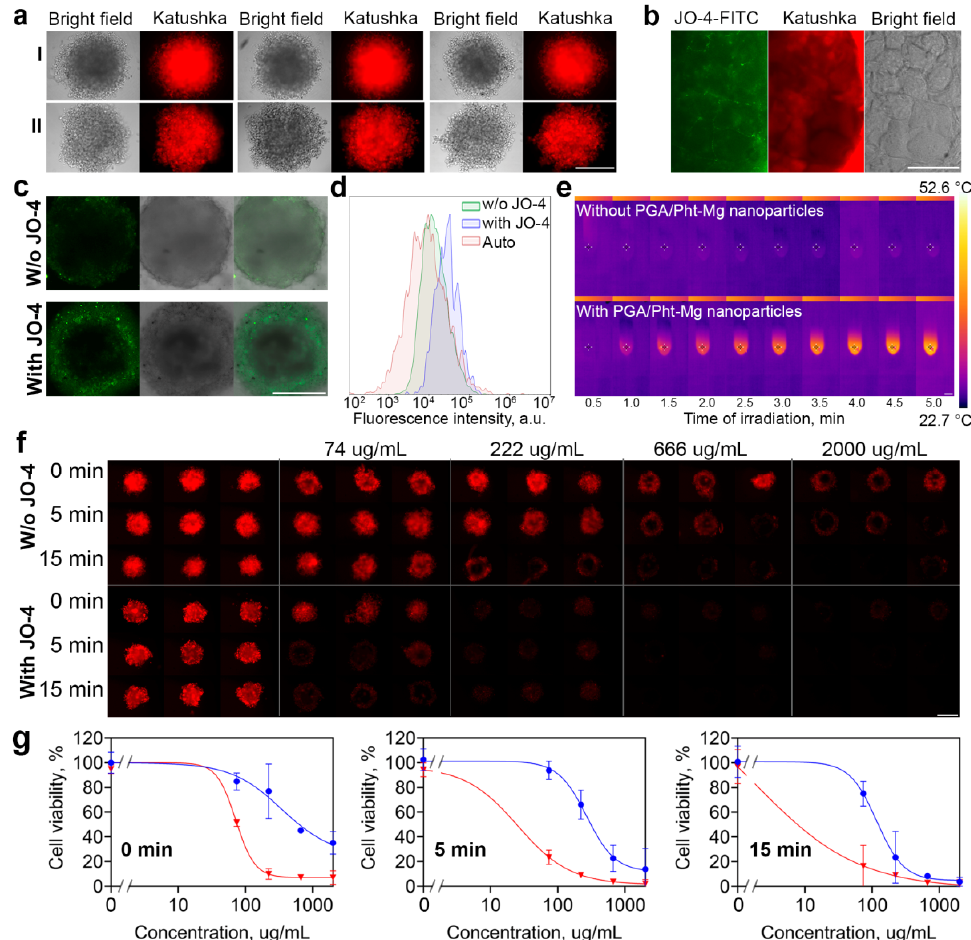
Figure 3. JO-4 enhances the therapeutic and diagnostic capabilities of polymer PLGA-based pho- tothermal sensitizers in vitro. ( a ) Bright-field and fluorescent images of 3D cell spheroids based on SKOVip-Kat cells cultured in agarose molds for 9 days before (I) and after (II) the removal from agarose microwells. Scale bar, 250 µm. ( b ) JO-4 conjugated with FITC interacts with the tight junctions of SKOVip-Kat cells. Scale bar, 20 µm. ( c ) Confocal microscopy images of 3D spheroids labeled with PLGA/Pht-Mg nanoparticles with or without preincubation with JO-4 protein. Images are presented in the fluorescence channel corresponding to the fluorescence of Pht-Mg (excitation 640 nm, emission 660–760 nm, the image is pseudocolored with green color), in the bright field and as a merged image of bright field and fluorescence. Scale bar, 250 µm. ( d ) Flow cytometry assay on evaluation of PLGA/Pht-Mg labeling of cells in spheroids. Spheroids were labeled with PLGA/Pht-Mg with or without preincubation with JO-4 protein, disaggregated with trypsin solu- tion and analyzed with flow cytometry (excitation laser 640 nm, emission filter 675/30 nm). ( e ) Thermal imaging of cell suspension with or without PLGA/Pht-Mg nanoparticles under the irra- diation with 808 nm laser with FLIR One camera. Scale bar, 1 cm. ( f ) Epifluorescent images of 3D spheroids of SKOVip-Kat cells incubated with PLGA/Pht-Mg nanoparticles loaded with Pht-Mg and irradiated with NIR light for 0, 5, and 15 min. Scale bar, 250 µm. (g) Fluorescence-based cyto- toxicity curves for SKOVip-kat spheroids incubated with PLGA/Pht-Mg and irradiated for 0, 5, or 15 min with or without pre-incubation with JO-4 protein.